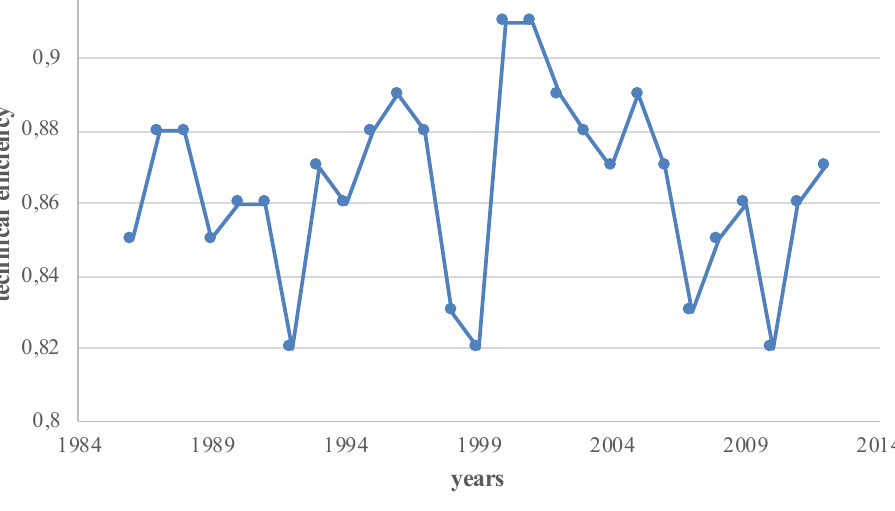
Source: Own elaborations on FADN